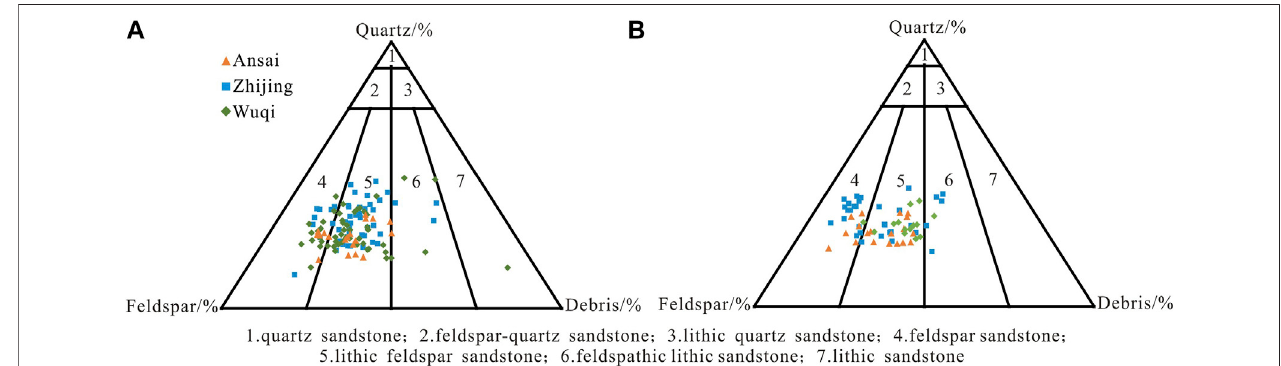
FIGURE 2 | Triangle diagram of rock types of Chang 8 1 (A) and Chang 8 2 (B) sandstones in Wuqi – Zhijing – Ansai